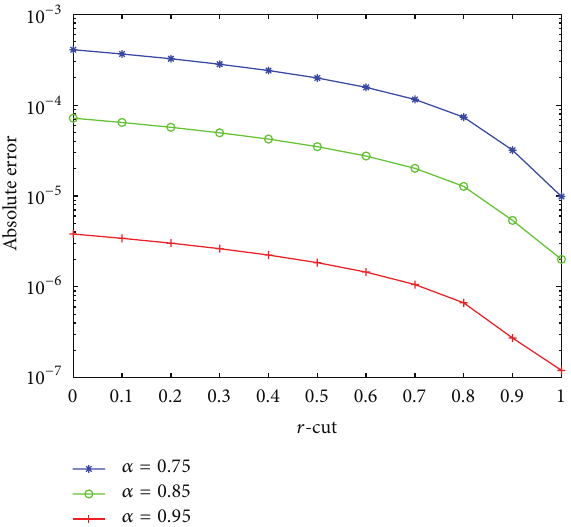
Figure 6: The absolute error for different 𝑚 of Example 57, 𝛼 = 0.95 .